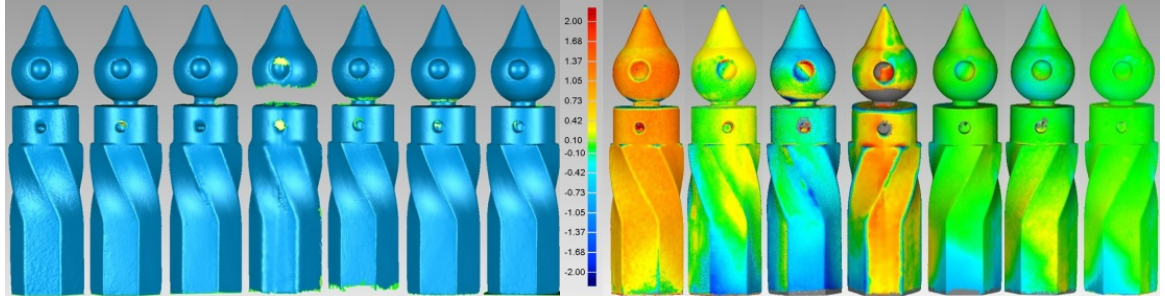
Figure 7. 3D models of Testy (left) and 3D deviation analyses using Geomagic 2012 (right) in the sequence (f.l.t.r.)